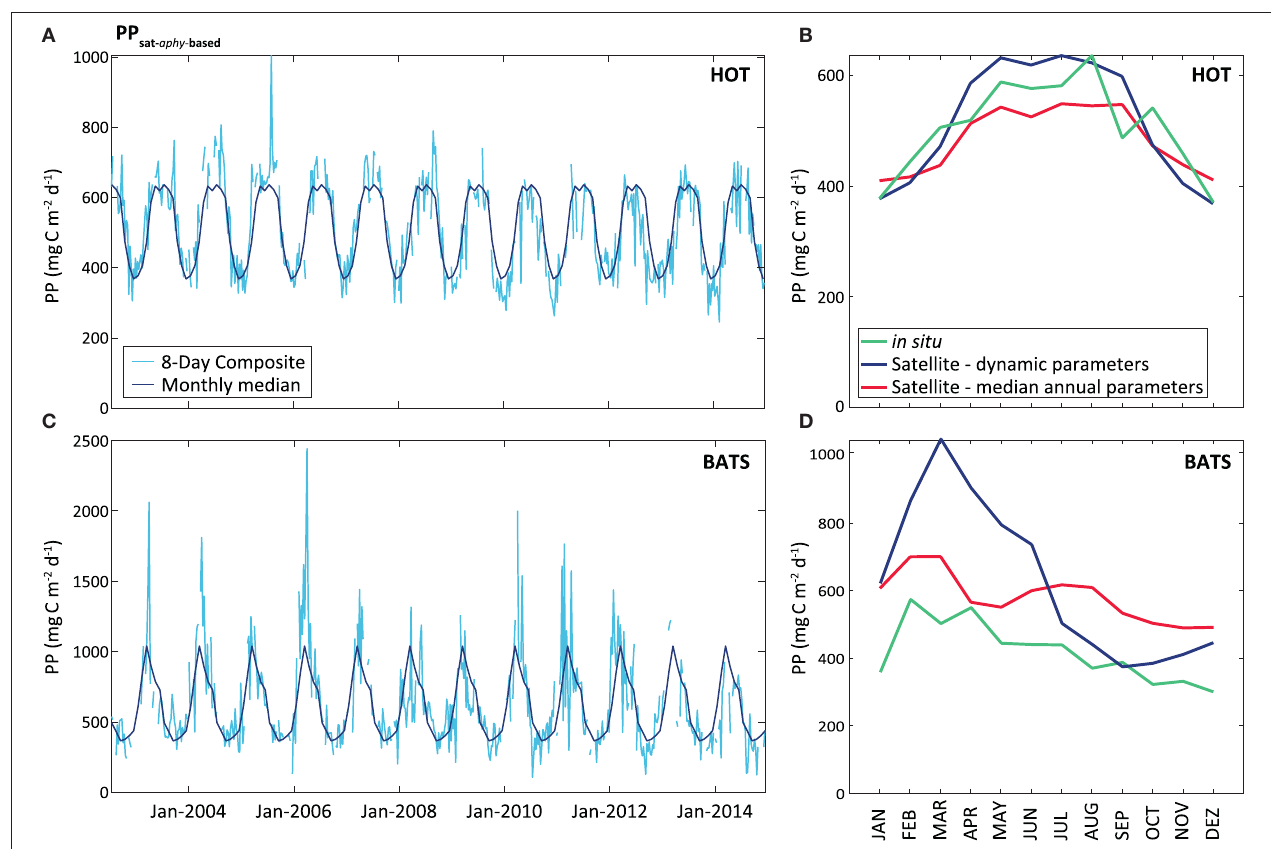
FIGURE 8 | PP sat (expressed in mg C m − 2 d − 1 ) obtained through the a phy model using temporal dynamic parameterization. The light blue line represents the results obtained for the 8-Day composite, while the dark blue represents the monthly median calculated for these data, at HOT (A) and BATS (B) . The graphs on the right shows a comparison between satellite and in situ PP estimates (monthly median of the PP sat − aphy − based using our dynamic parameterization in the blue line, monthly median of the PP sat − aphy − based using both parameters as constant in the red line, and monthly median of the PP in situ in the green line), for HOT (C) and BATS (D)